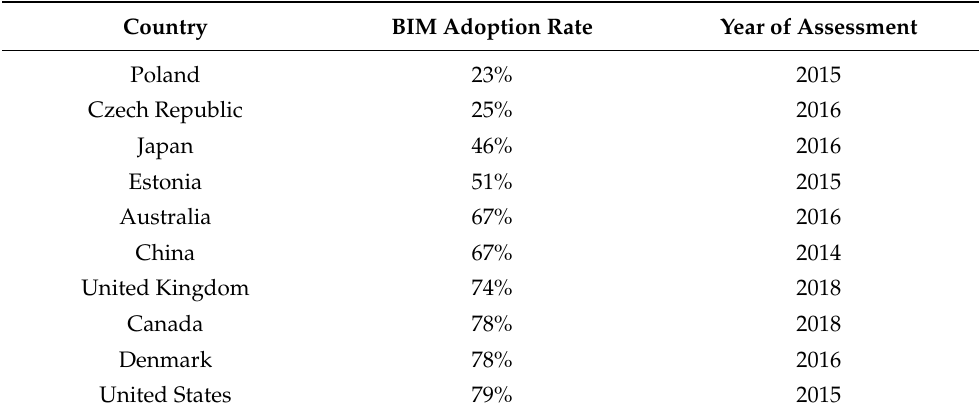
Table 1. BIM adoption rate among countries compiled by [24] sourced from various studies in these countries. Country BIM Adoption Rate Year of Assessment